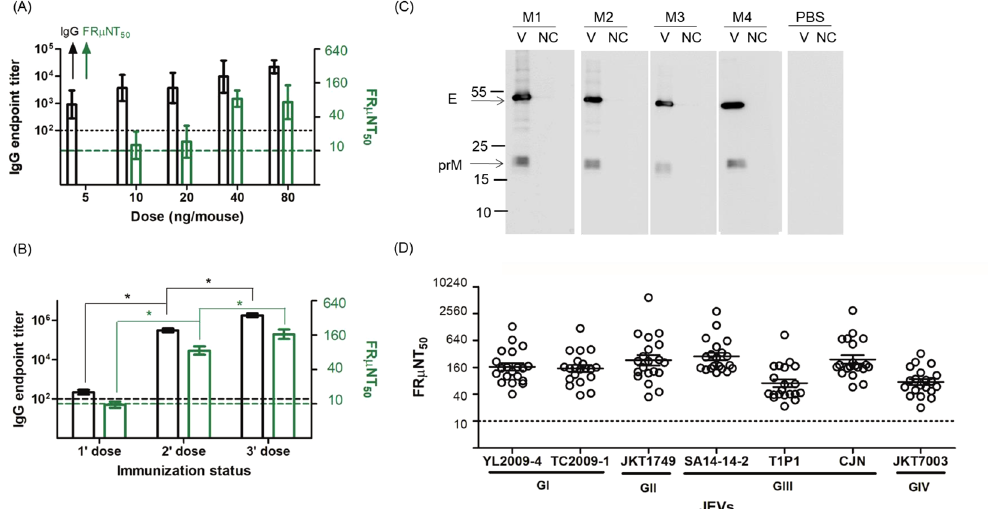
Figure 2. Immunogenicity of GI JEV VLPs in mice. ( A ) BALB/c mice (5 mice each group) received 2 doses of 5, 10, 20, 40, or 80 ng GI VLPs subcutaneously, then the IgG antibody (black, left y-axis) and neutralizing activity (green, right y-axis) were measured by mouse IgG antibody capture (GAC)-ELISA and focus-reduction micro-neutralization (FR μ NT) assay. ( B ) 20 BALB/c mice were vaccinated with 1, 2, or 3 doses of 40 ng GI VLPs, and the endpoint titers of IgG antibodies against VLPs (black, left y-axis) and homologous neutralizing activity (green, right y-axis) were estimated by mouse GAC-ELISA and FR μ NT assay. ( C ) The reactivity of IgG antibodies against GI YL2009-4 virus proteins (V) and the cellular supernatant (NC; negative control) among 3-dose PBS- or GI VLP-immunized mice (M1 to M4) were analyzed by Western blot assay. Full-length Western blots are presented in Supplementary Fig. S6. ( D ) The heterologous neutralizing antibodies elicited by 3 doses of GI VLP against GI, GII, GIII, and GIV JEVs were determined by FR μ NT 50 . Data are mean ± SD compared by Student t test, one-way ANOVA, or post-test with Turkey’s Multiple Comparison Test. * P <